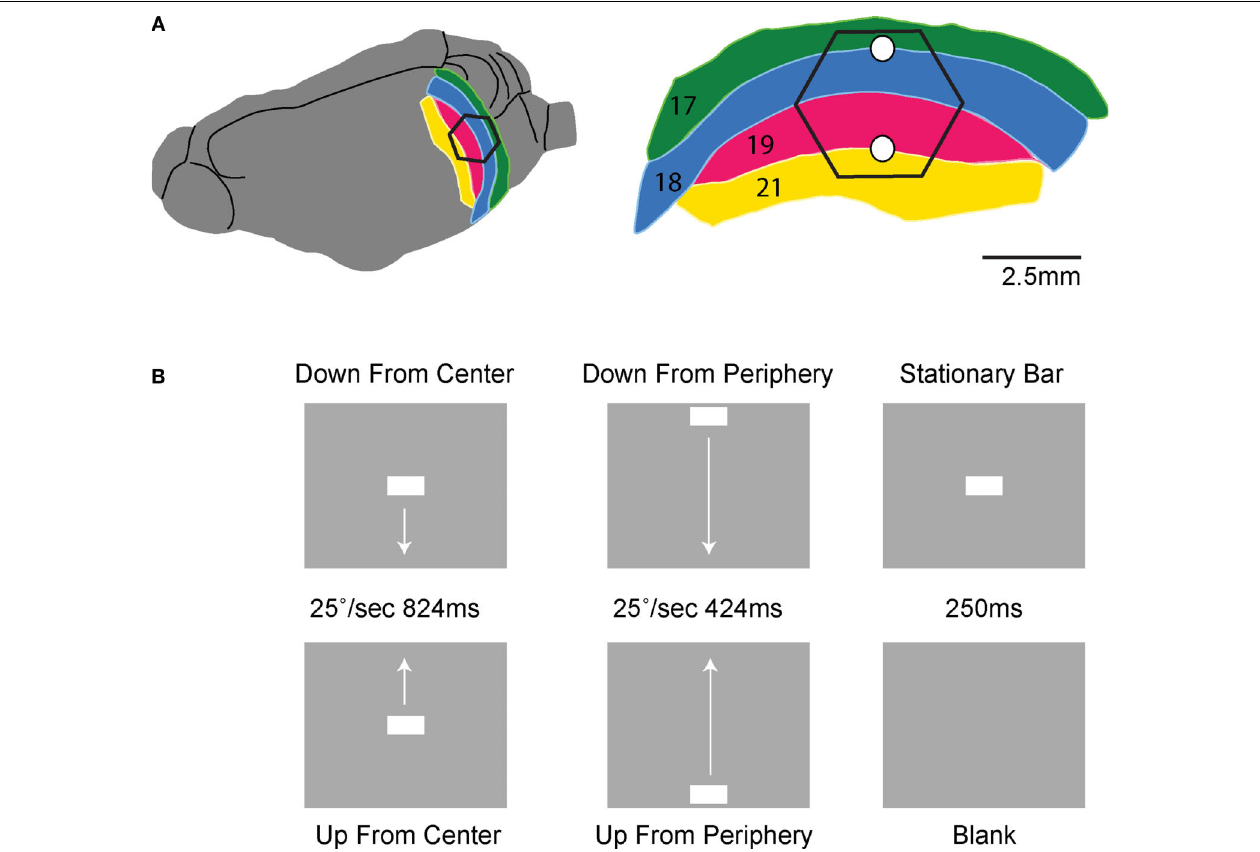
The two white dots mark the expected mappings of the CFOV. The relation between hexagon borders and cytoarchitectural borders (and hence the CFOV mapping) vary somewhat between animals. Each diode picks up a signal from a cortical spot of 150 µm in diameter. (B) The stimulus conditions. All stimulus conditions were compared to a gray screen (blank